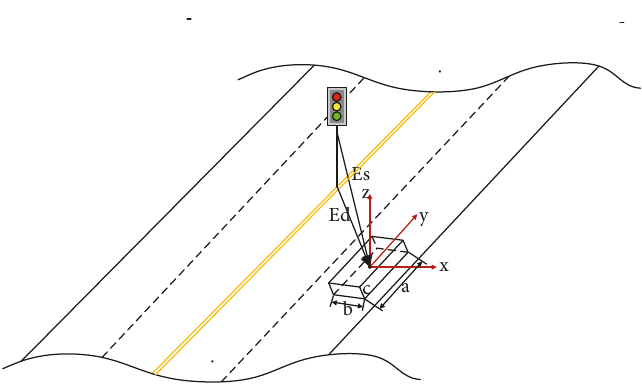
Figure 4: Static field strength (Es) and dynamic field strength (Ed) of independent pressure source.